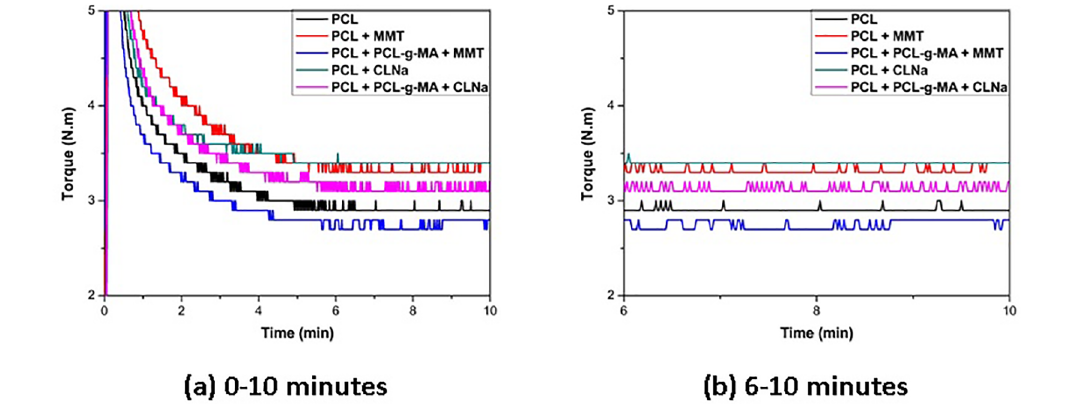
Figure 1. Torque versus time for PCL, PCL/MMT, PCL/PCL-g-/MMT, PCL/CLNa and PCL/PCL-g-MA/CLNa compounds Figure 1a. Constant plateau for the interval time ranging from 5 to 10 min Figure 1b. Compounding parameters: 160°C, 60 rpm, 10 min.